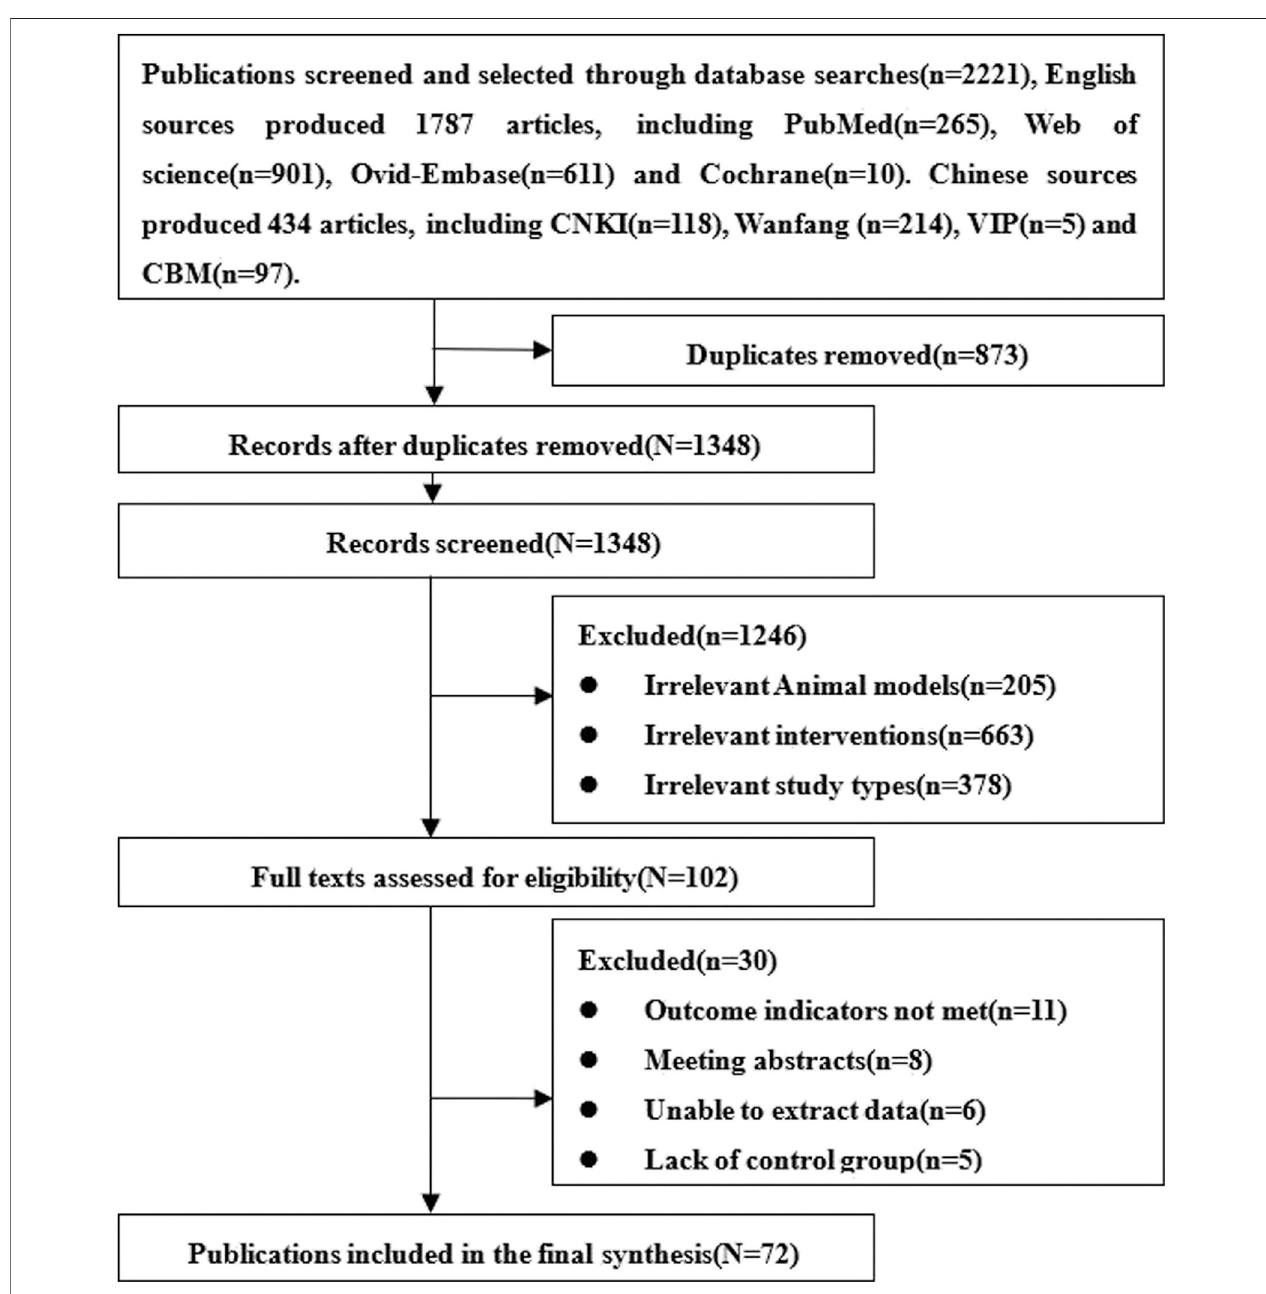
FIGURE 1 | Study screening and selection